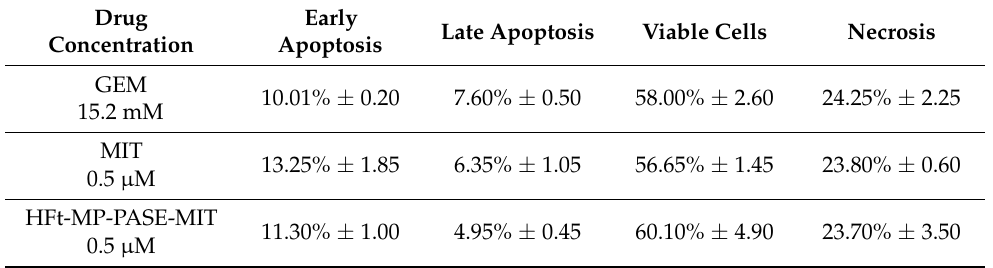
Table 1. PaCa44 cell apoptosis detected by flow cytometry after 48 h of treatment. Drug concentration